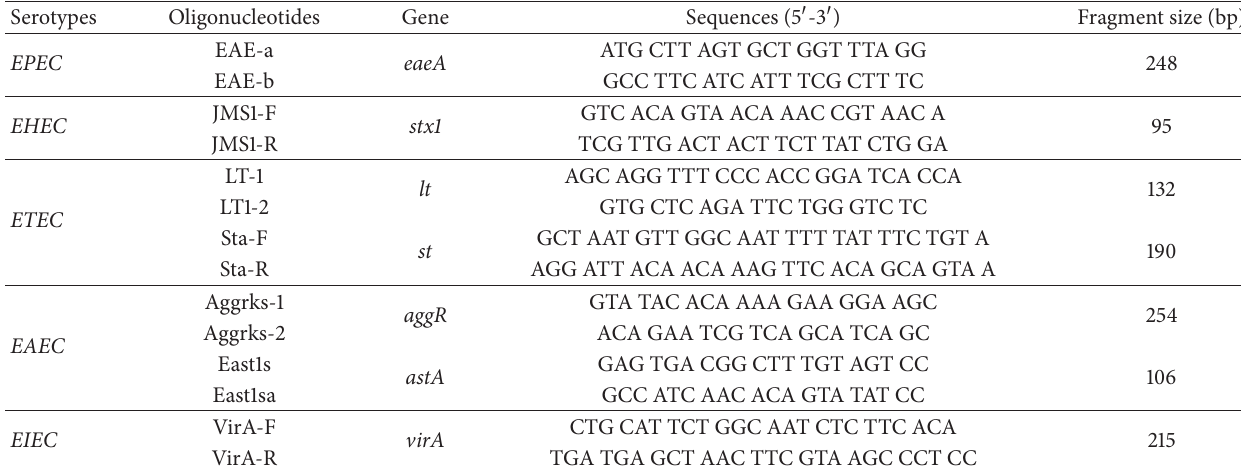
Table 1: Primer sequences used for the identification of Escherichia coli virulence.